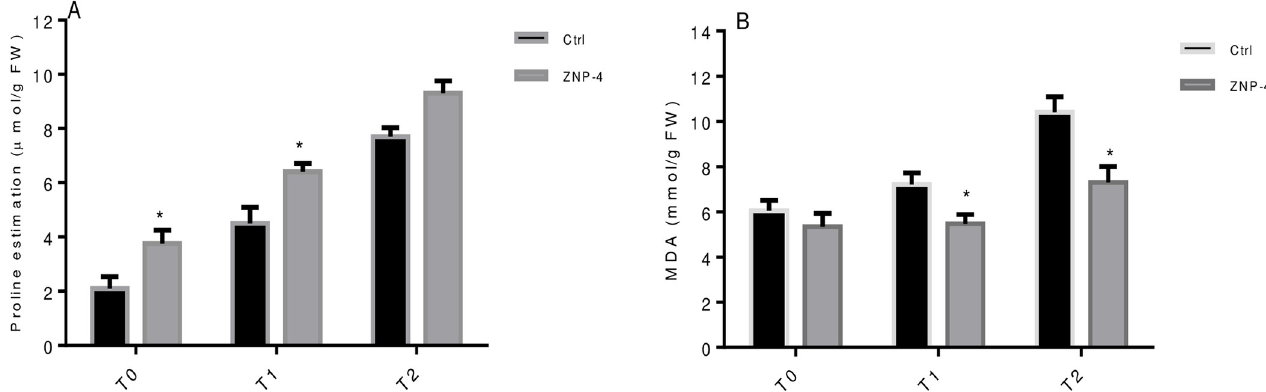
Fig 8. Effect of bacterium inoculation on proline and malondialdehyde content under tested salinity treatments (A) proline content (B) malondialdehyde content. Error bar represents standard deviation of five measurements in triplicate sets (n = 15). � represent the significant difference as compared to corresponding control as per Ducan’s multiple range test (p = 0.05).